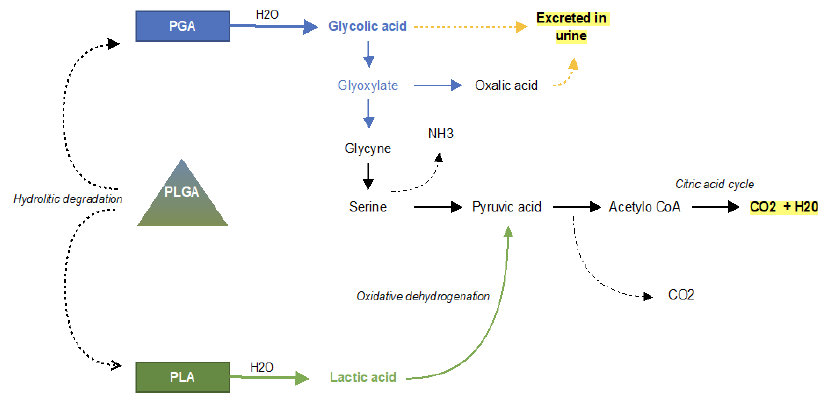
Figure 2. Schematic illustration showing the degradation of PLGA co-polymer and the PGA and PLA monomers. As a result, carbon dioxide and water are finally produced.